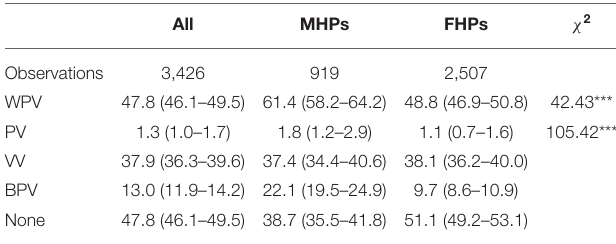
TABLE 2 | Prevalence of different types of workplace violence among male and female healthcare professionals [% (95% CI)].